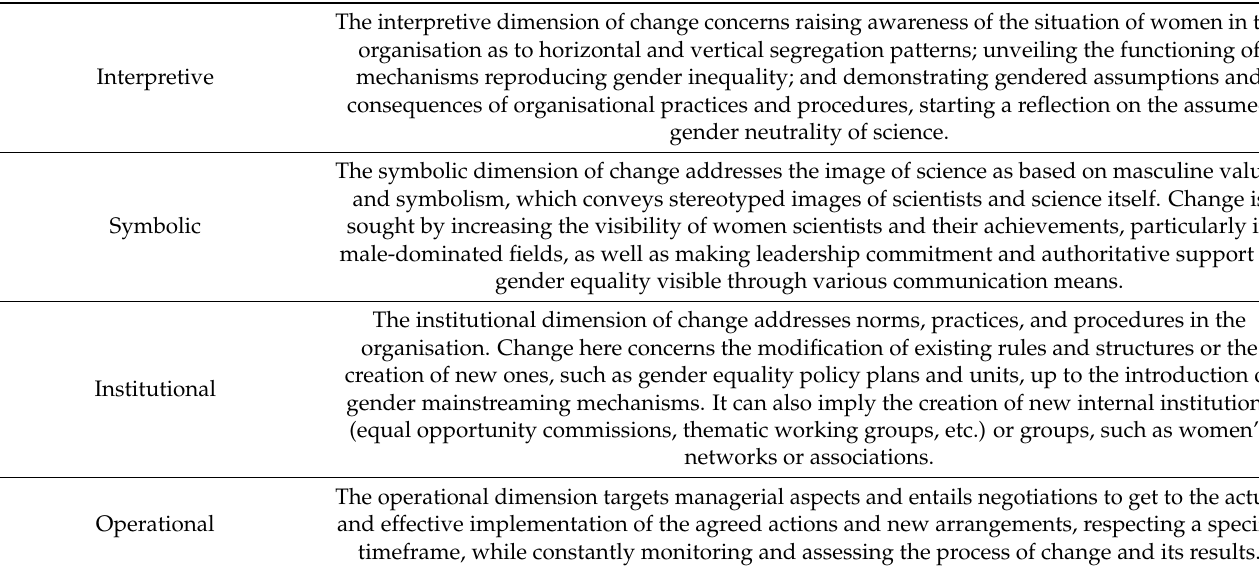
Table 2. The multiple dimensions of institutional change (Kalpazidou Schmidt and Cacace